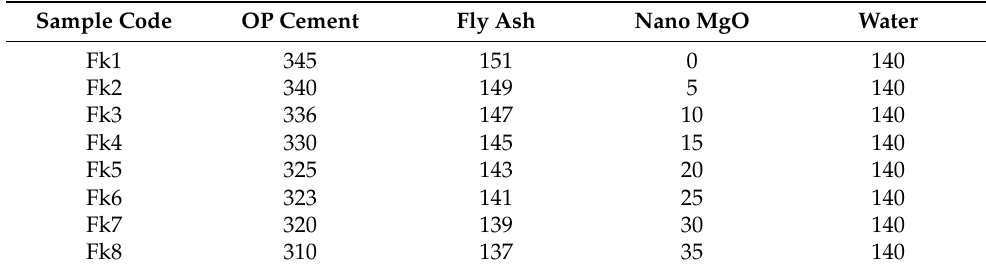
Table 1. Mixing ratio of cement